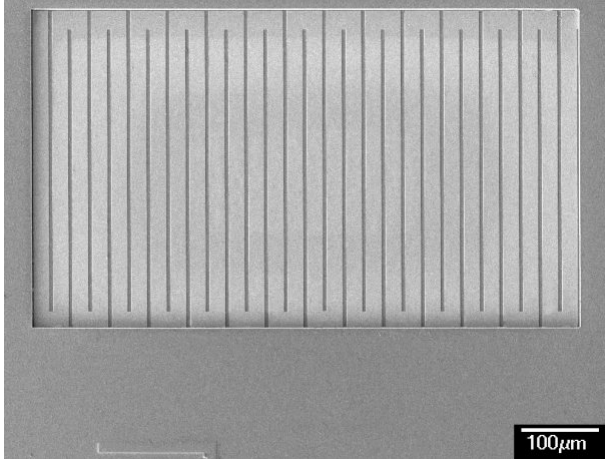
Figure 10. SEM image of the CO sensor after the wet etching